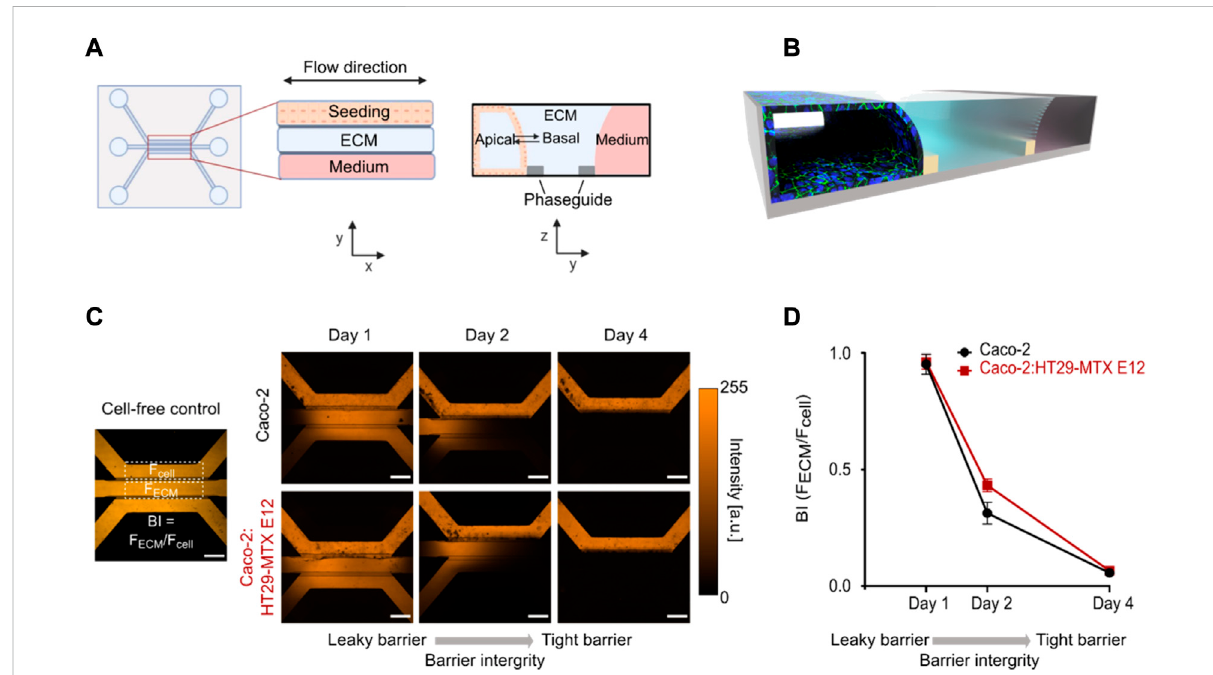
FIGURE 1 Mono-and coculturesystemsproduceleak-tightepithelialmonolayertubulesafter 4 days. (A) Design ofthe3-lane OrganoPlate system witha topview(left)andsideview(right)illustratedin2d. (B) 3D-schematic oftheonechipafter theformation ofanepithelial monolayertubule stainedfor tightjunctions(green)andcellnuclei(blue)intheseedingchannel. (C) MicrographsdisplayingTDdistributionincellfreecontrol(left)andinperfused mono-and coculture chips at days 1, 2, 4 post seeding (right). (D) Quantifying the BI of mono- and coculture tubules by depicting the BI determined astheratiobetweentheTDintensity intheECMchannel(F ECM )andseedingchannel(F cell )(seeC)asafunctionofdayspostcellseeding. Error bars represent the standard deviation ( n = 3). Scale bar in all micrographs is 500